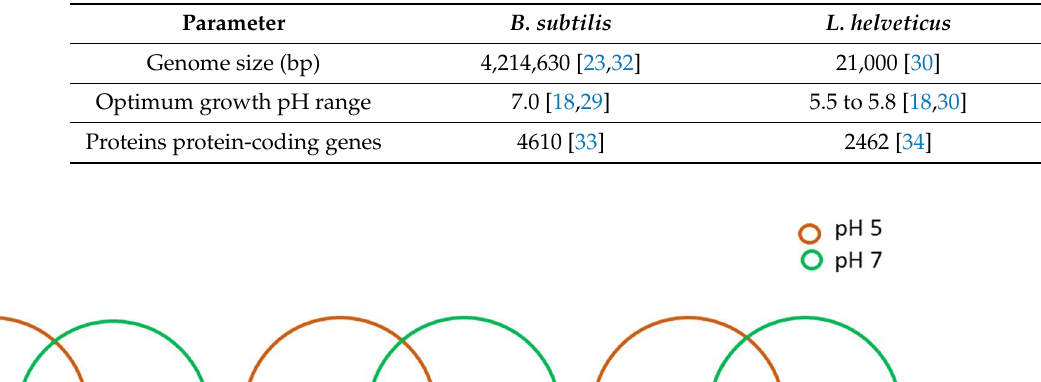
Table 1. Summary of general characteristics of the bacterial species closely related to the studied strains ( B. subtilis (EB2004S) and L. helveticus (EL2006H)) in previous studies. Parameter B. subtilis Genome size (bp)